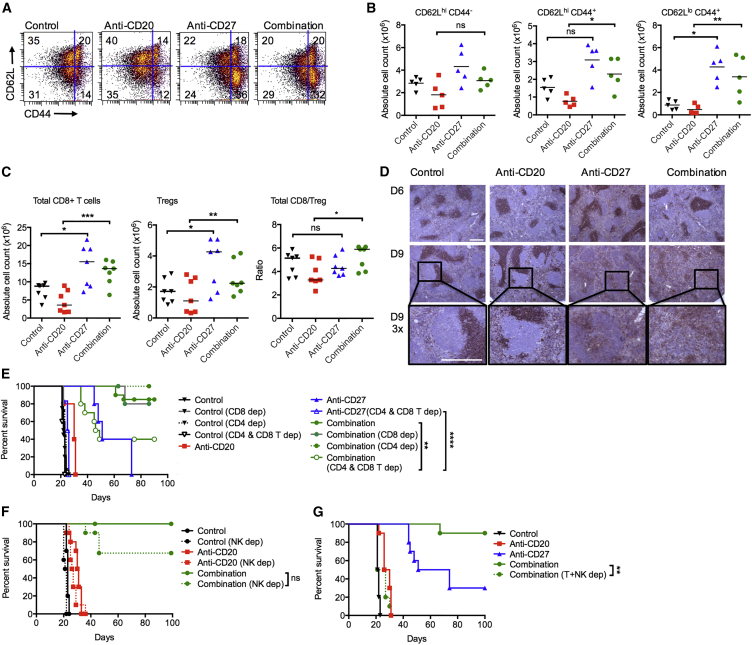
Anti-CD27 Stimulation of CD8+ T cells(A–C) BCL1-bearing mice were treated as described in Figure 2A, and spleens were harvested on day 13. Cell counts were obtained, and cells were analyzed by flow cytometry. (A) Representative flow cytometry plots showing the percentages of activated CD8+ T cells, denoted by CD62L and CD44 expression, upon treatment with either control, anti-CD20, anti-CD27, or in combination. (B) Graphs showing cumulative data from (A), n = 5 per group, medians shown. (C) Graphs show absolute numbers of CD8+ T cells, Tregs, and CD8+/Treg ratio, n = 7 per group, medians shown, ns indicates not significant. Student’s t test was used for (B) and Wilcoxon test for (C) to assess p values; ∗p < 0.05, ∗∗p < 0.01, ∗∗∗p < 0.001.(D) BCL1-bearing mice were treated as in (A), and spleens were harvested on days 6 and 9 and stained for CD8 by immunohistochemistry. Both scale bars represent 500 μm. Boxed inset enlarged ×3.(E) BCL1-bearing mice were depleted of CD8+, CD4+, or both cell types, and treated as described in Figure 2A. Graphs show n = 5–10 per group, representative of two independent experiments, ns indicates not significant.(F) BCL1-bearing mice were depleted of NK cells and treated with isotype control, anti-CD20, anti-CD27, or the combination. Graphs show n = 5–10, from two independent experiments, ns indicates not significant.(G) BCL1-bearing mice were depleted of T and NK cells, and treated with isotype control, anti-CD20, anti-CD27, or the combination. Graphs show n = 5, representative of two independent experiments.Log-rank test was used to assess p values; ∗∗p < 0.01, ∗∗∗∗p < 0.0001. See also Figure S2.